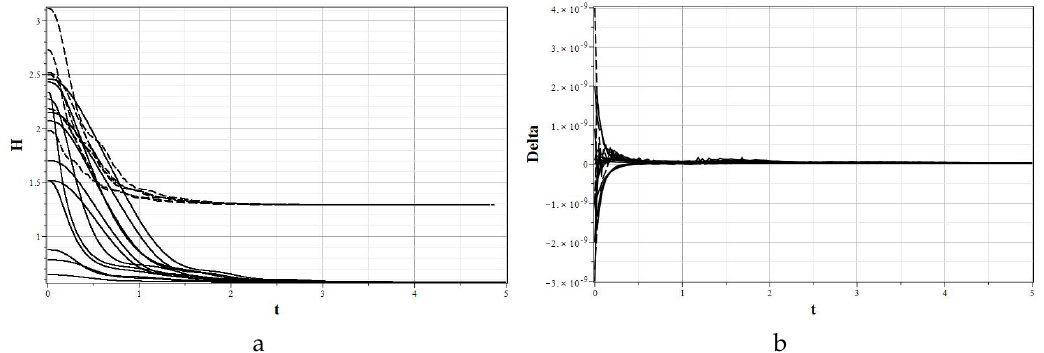
Figure 6. Dependence of H on t ( a ); deviation of the integral of motion ∆ ( t ) from zero ( b